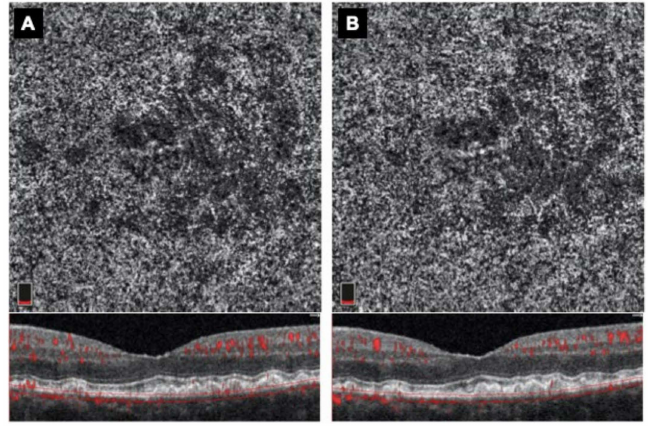
Figure 4. En-face OCTA slab of choriocapillaris and co-registered b-scan with flow overlay (shown in red) at baseline ( A ) and after 6 months ( B ).